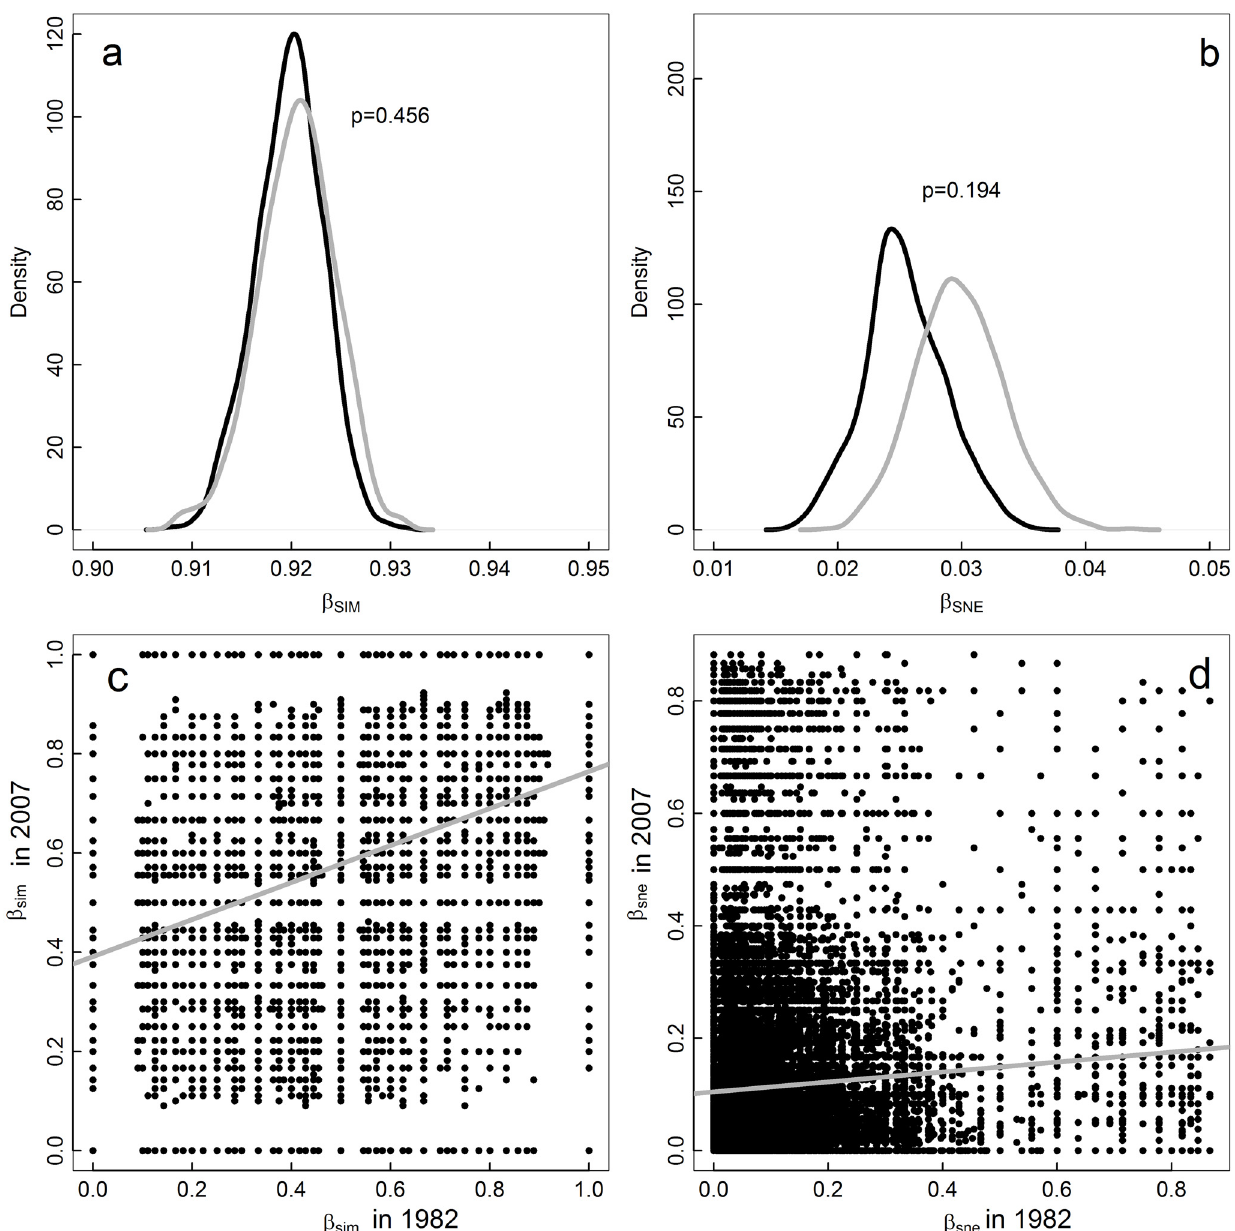
Fig 2. Temporal variation in spatial beta diversity. (a) and (b) show the distribution of multiple site dissimilarity in 1982 (black) and 2007 (gray) for the turnover ( β SIM ) and nestedness-resultant ( β SNE ) components, respectively, after resampling multiple-site dissimilarity values for 50 localities 1000 times. (c) and (d) show the correlation between spatial pairwise dissimilarity in 1982 and spatial pairwise dissimilarity in 2007 for the turnover ( β sim ) and nestedness- resultant ( β sne ) components, respectively. The gray lines are the linear